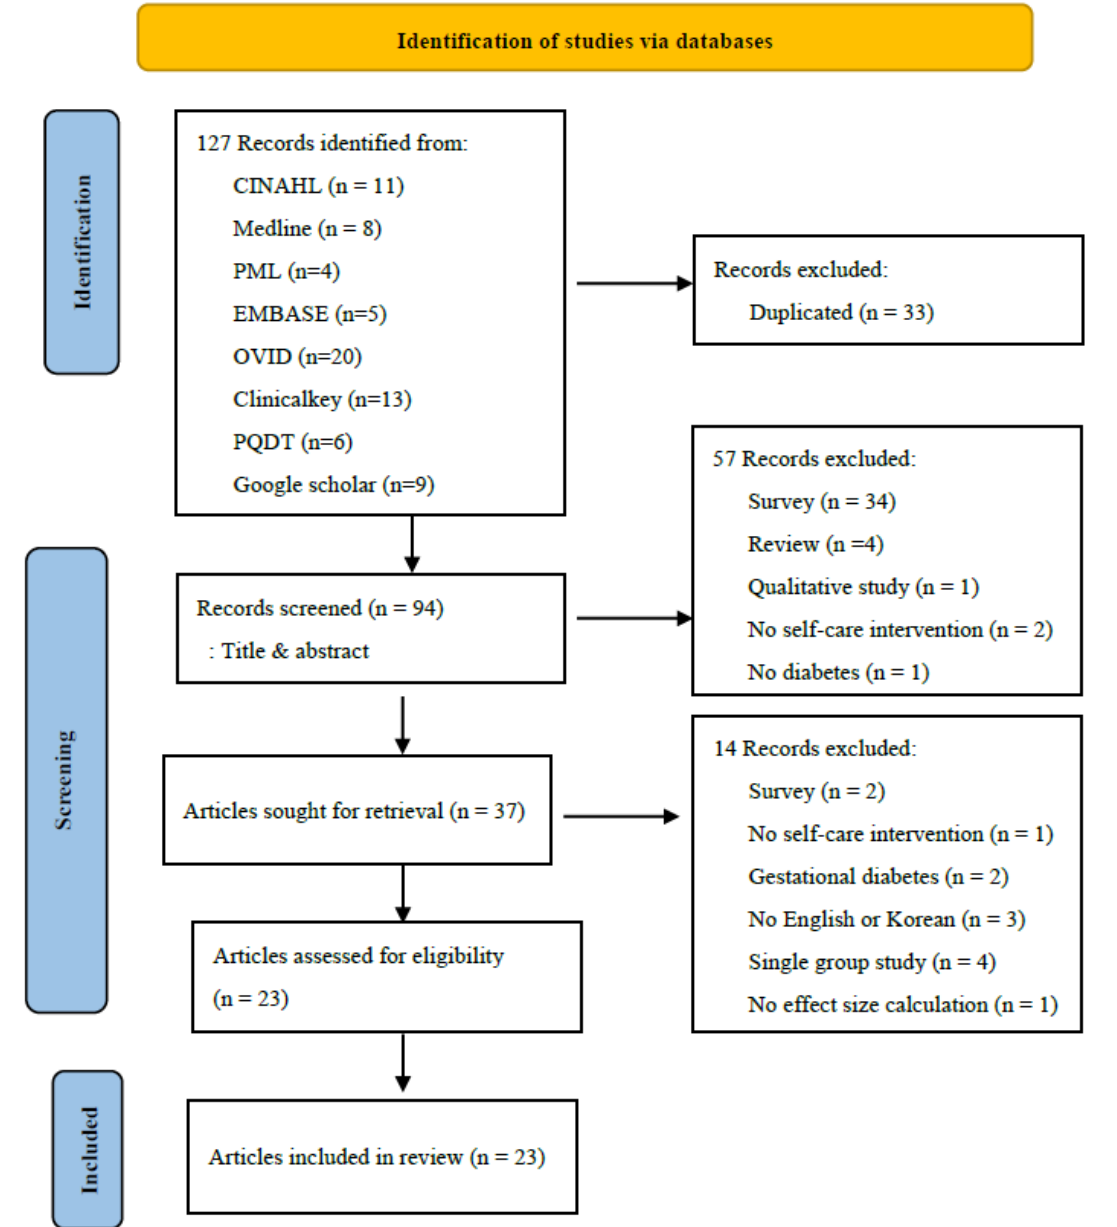
Figure 1. Diagram of study extraction.